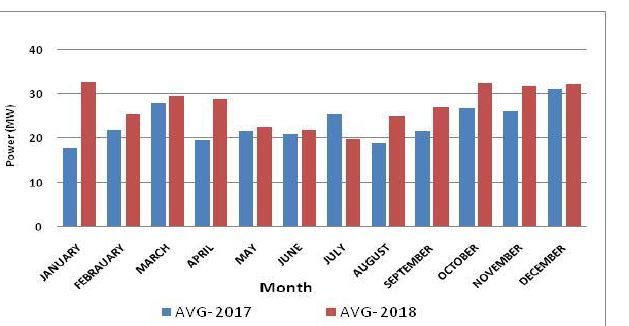
Figure 25. Comparison between average values of Figure 28. Comparison between RCIs for the average upward power ramps in 15 min interval for each month values of downward power ramps in 15 min interval for for years 2017 and 2018. each month for the years 2017 and 2018.